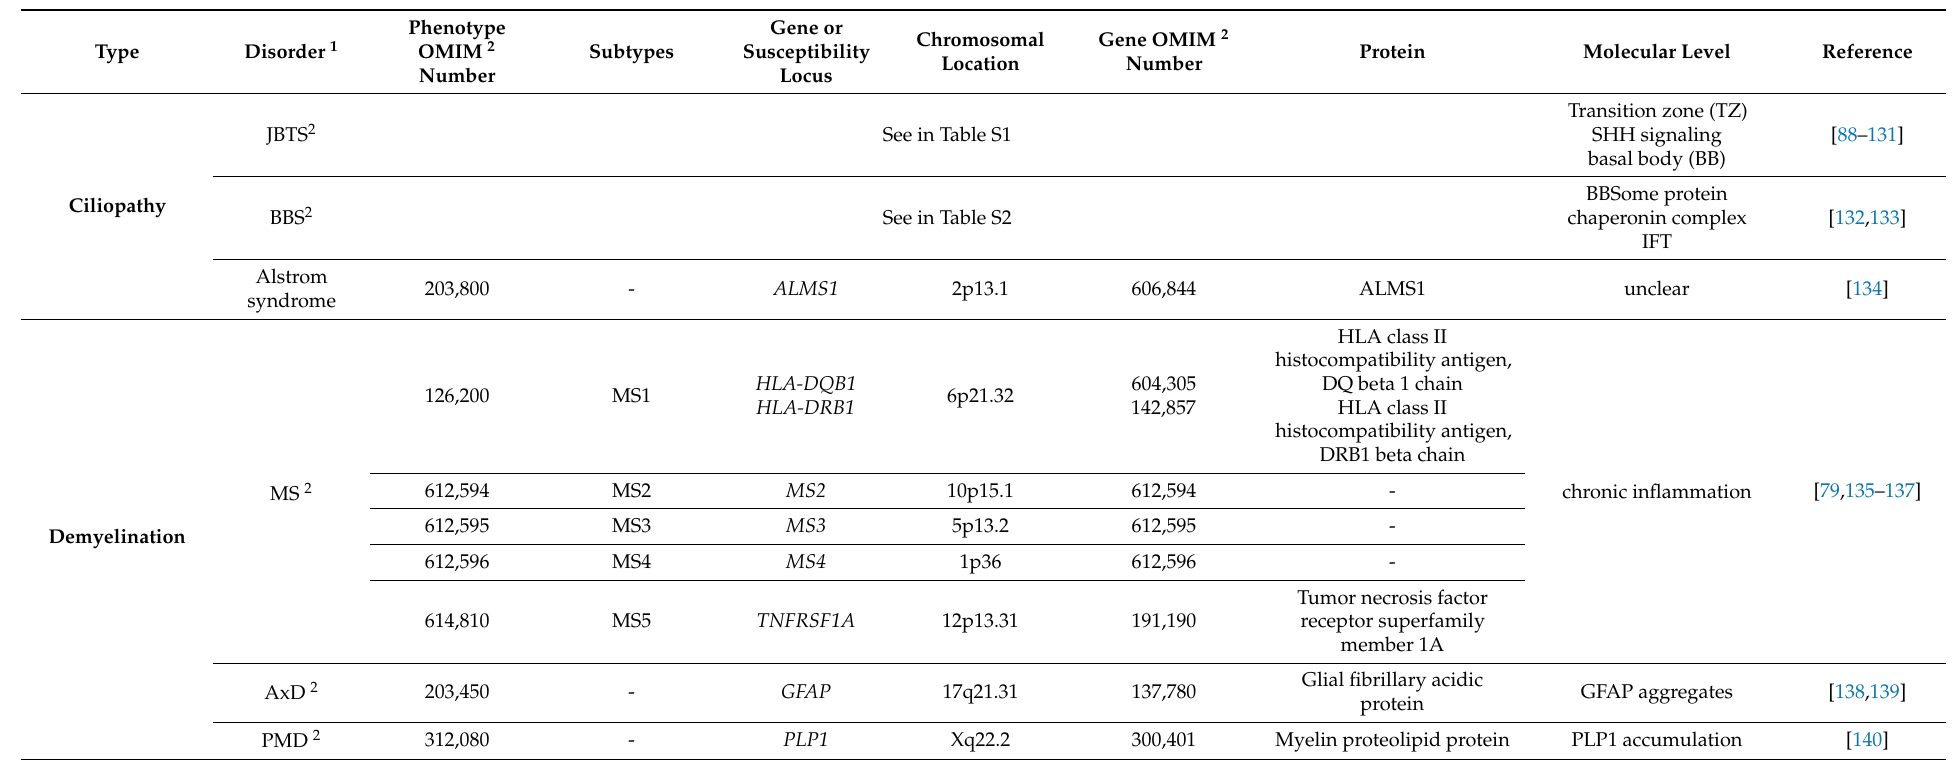
Table 2. Pathomechanisms of Cerebral Visual